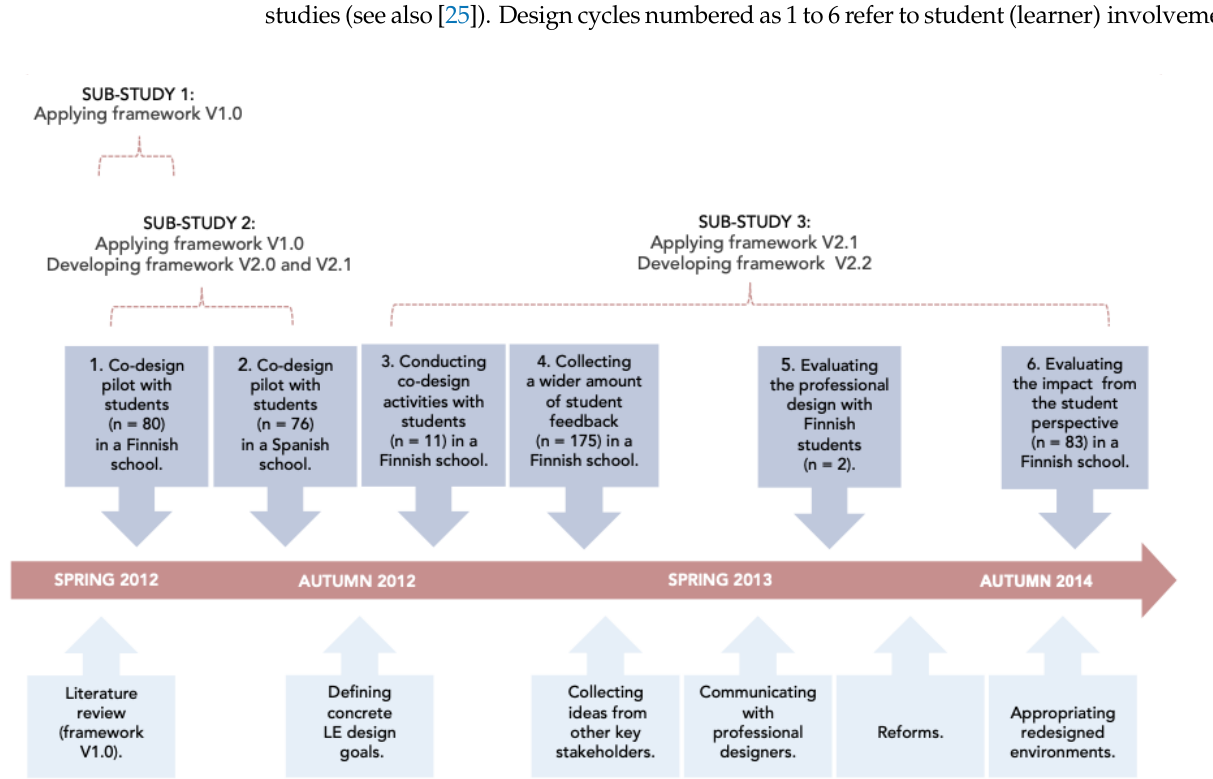
Figure 2. Design cycles in relation to sub-studies (Image by Mona Johansson in